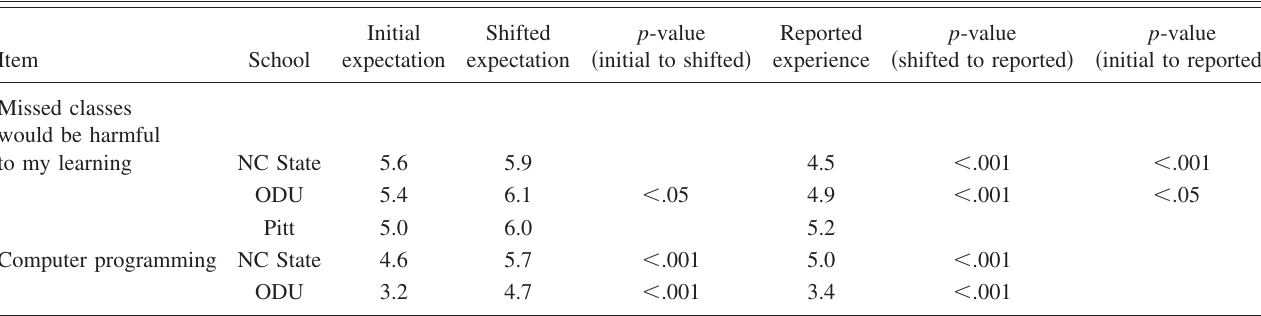
TABLE IV. Sample items fitting a “failure” profile.